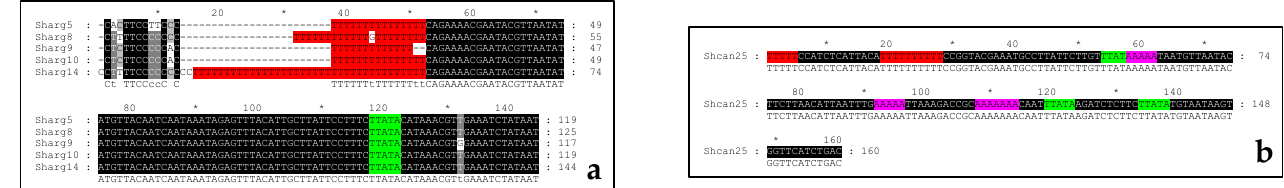
Figure 2. The alignment of Shepherdia argentea ( a ) and Sh. canadensis ( b ) non-transcribed spacers (NTSs). The poly-T regions are indicated by red. The poly-A region is indicated by pink. The TATA-like motifs are indicated by green.